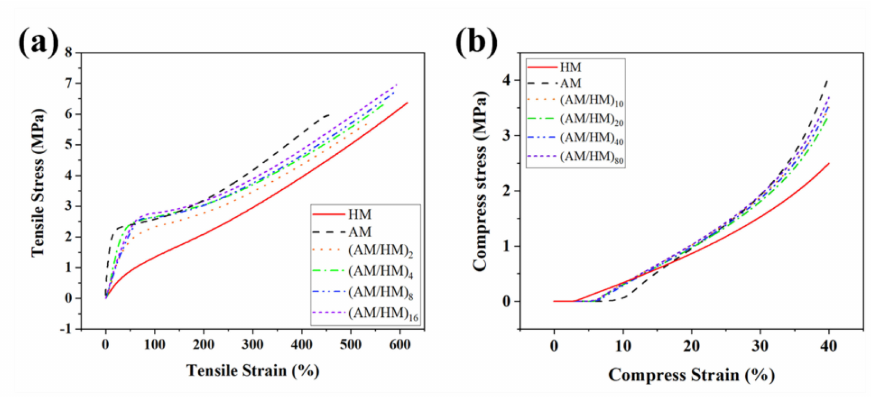
Figure 7. Tensile ( a ) and compressive ( b ) curves for the multilayer EPDM